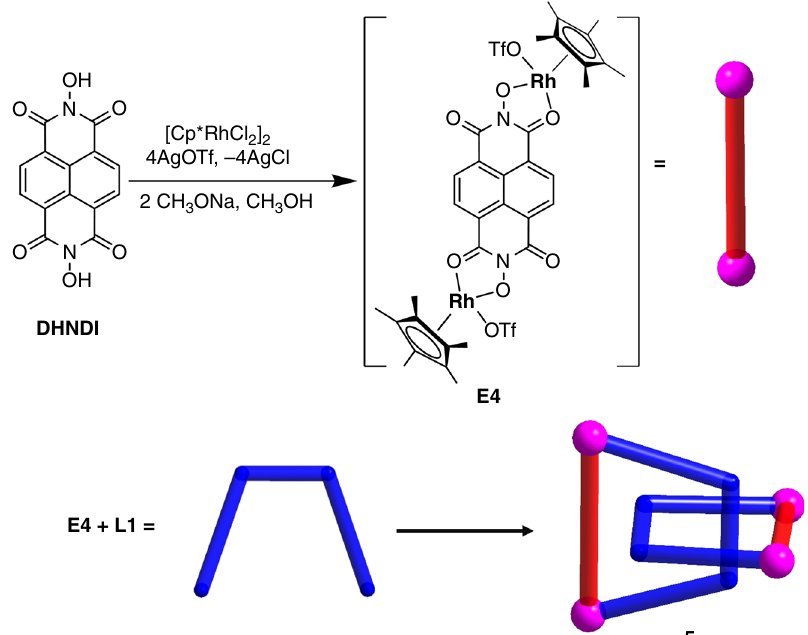
Fig. 8 Synthesis of [2]catenane complex 5 . Schematic representation of the synthesis of E4 (top) and stick model of 5 (below)